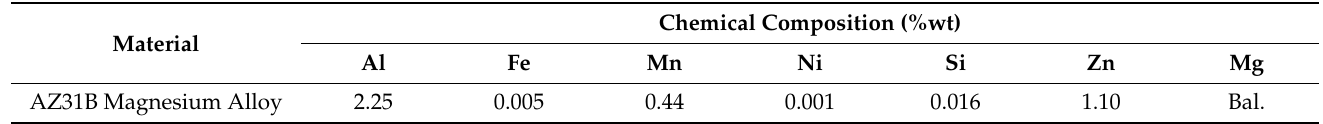
Table 1. AZ31B magnesium alloy chemical composition [30]. Copyright 2015